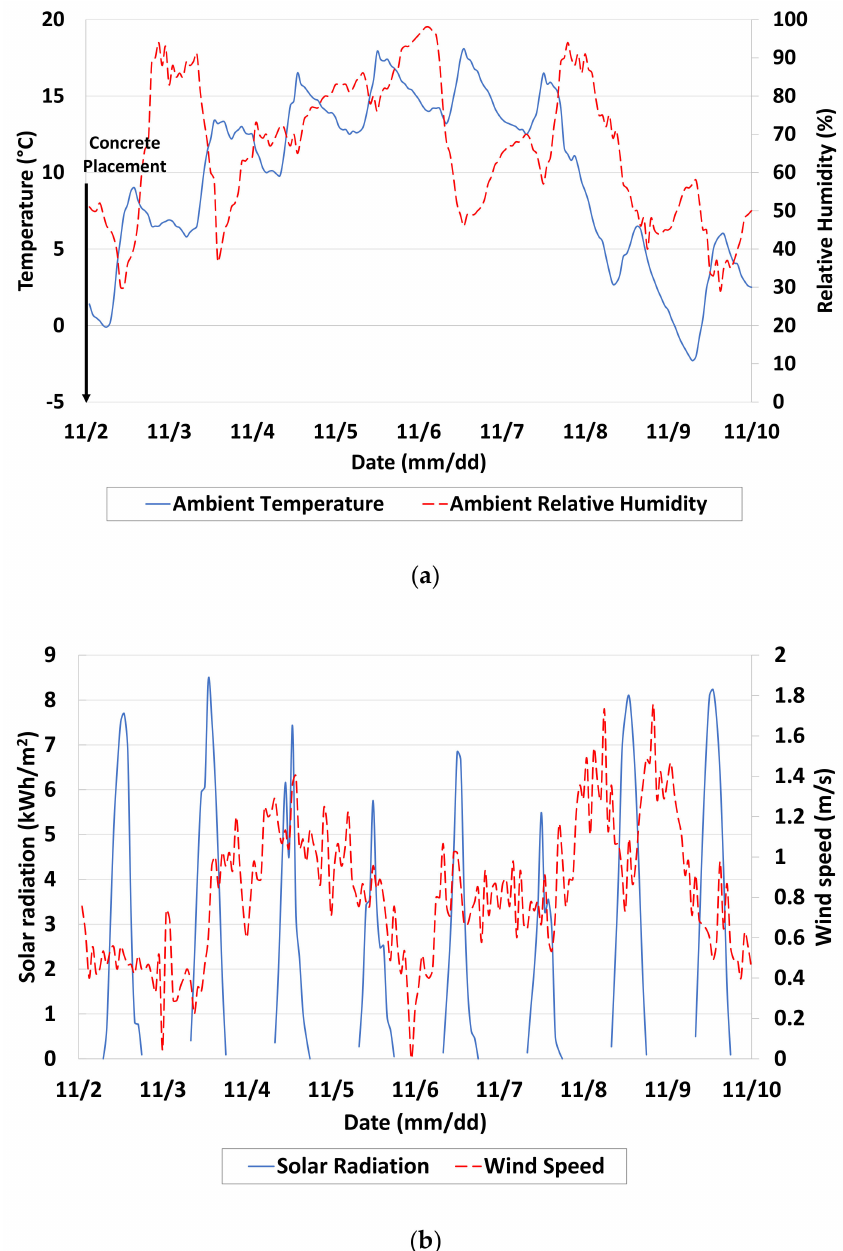
Figure 5. Weather data for the first seven days: ( a ) ambient temperature and ambient relative humidity and ( b ) solar radiation and wind